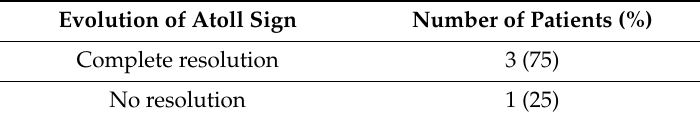
Figure 13. Presence of atoll signs (white arrowheads) in a patient with COP, which were still recognizable despite steroid therapy. Table 8. Evolution of the 4 patients with atoll sign. Table 8. Evolution of the 4 patients with atoll sign.